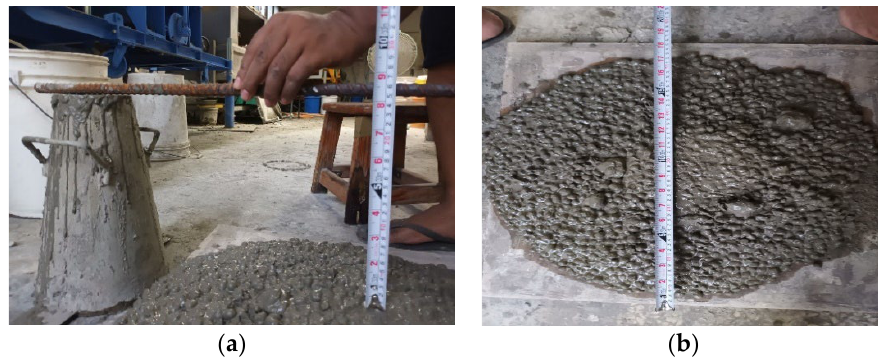
Figure 3. Slump cone test (height = 24.2 cm and slump flow diameter = 51 cm).